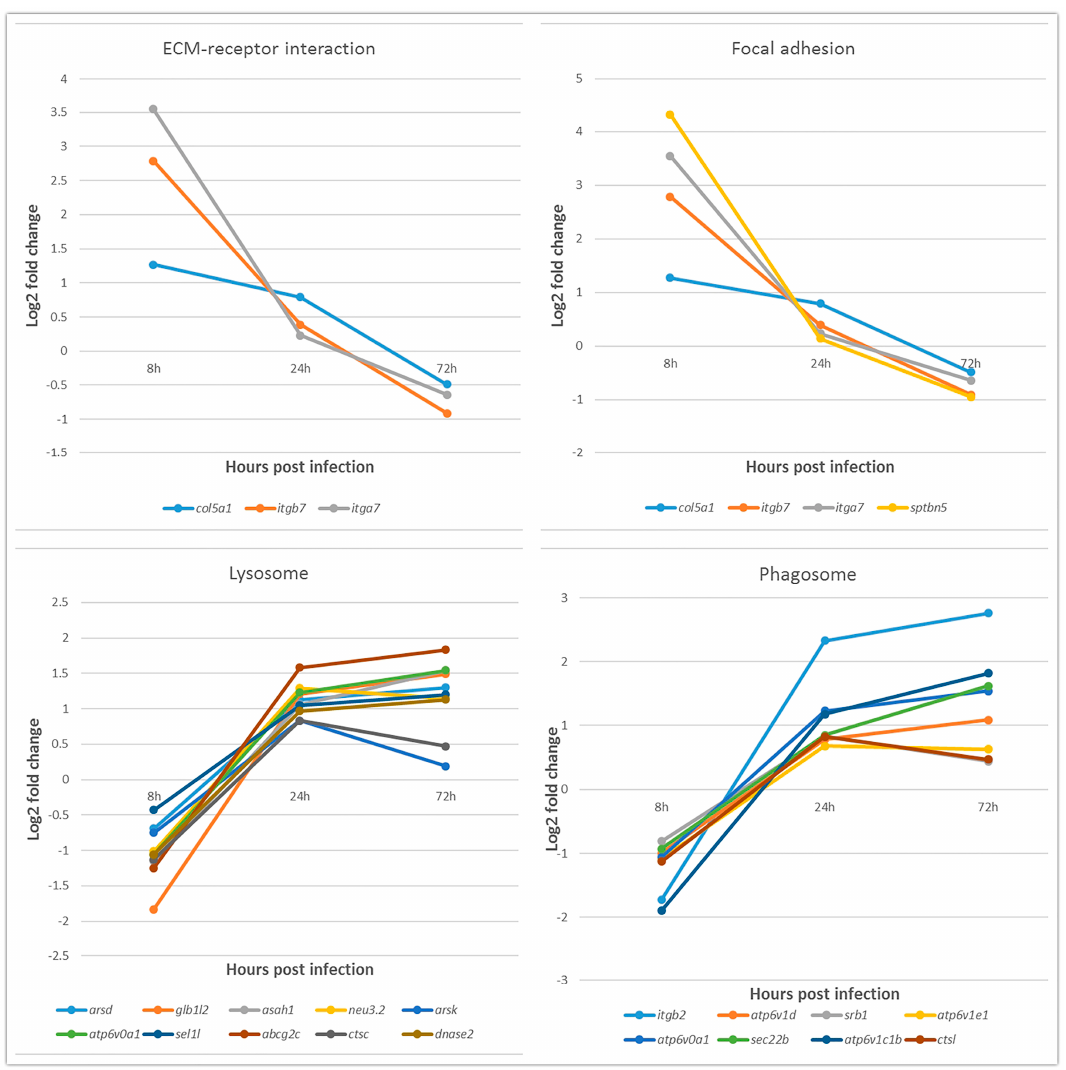
Figure 4. Line chart of gene expression patterns of differentially expressed genes (DEGs) in selected KEGG pathways. The x-axis is the hours post infection, and the y-axis is the log2 fold change in expression level. Lines of different colors represent different DEGs.